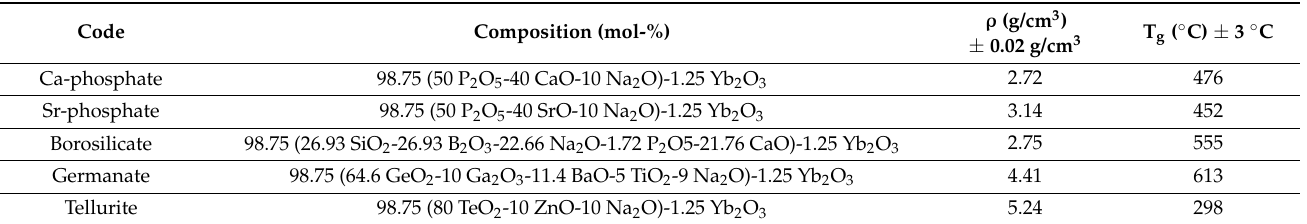
Table 1. Nominal composition, density and glass transition temperature (T g ) of the investi- gated